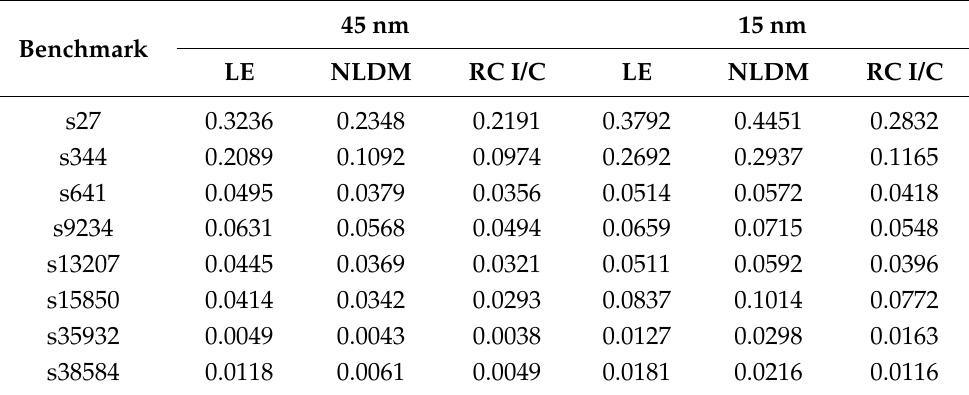
Table 8. SER estimation considering LE, NLDM, and RC interconnection approaches for the 45 nm and 15 nm technologies.